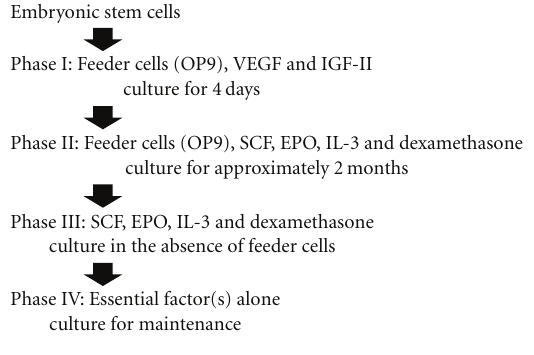
Figure 2: Culture protocol to establish erythroid progenitor cell lines from embryonic stem cells. In most cases, the cells failed to proliferate within two months of the initial induction of di ff erentia- tion from ES cells. Induced cells that could proliferate continuously for approximately two months (60 days) were subsequently cultured in the absence of OP9 cells and in the presence of hematopoietic humoral factors. Cells that could proliferate in the absence of OP9 cells were cultured further. Approximately four months after the initial induction of di ff erentiation of the cells, we evaluated the factors that were essential for the proliferation of each cell line. VEGF, vascular endothelial growth factor; IGF-II, insulin-like growth factor-II; SCF, stem cell factor; EPO, erythropoietin; IL-3, interleukin-3.